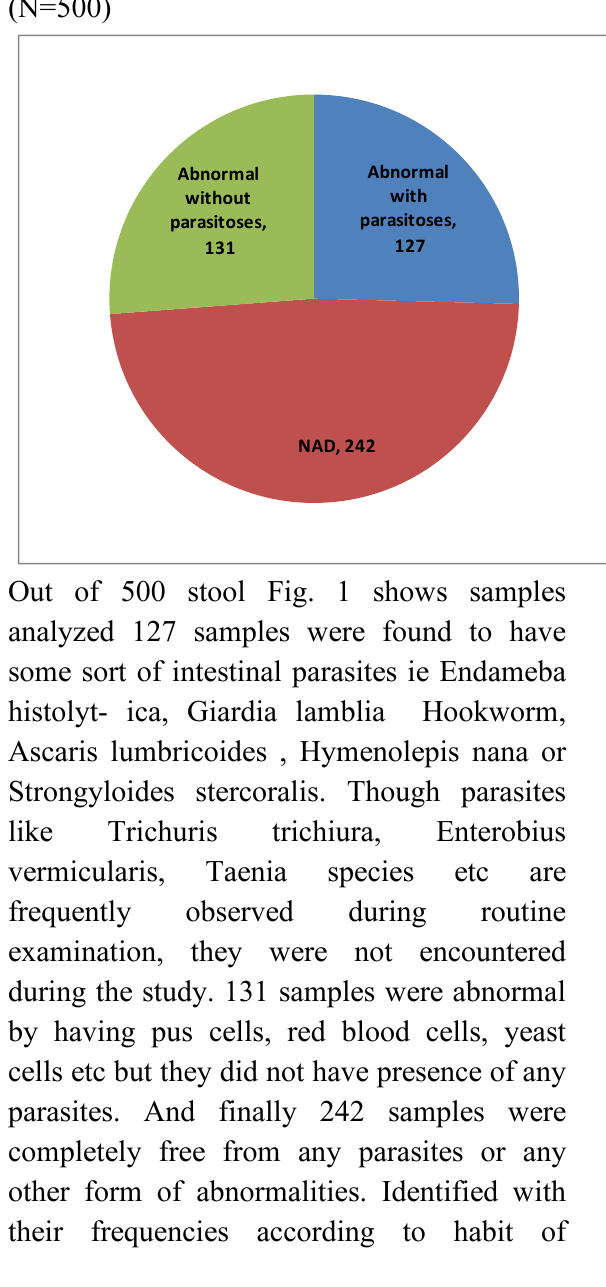
Figure1 Sample frequency based on